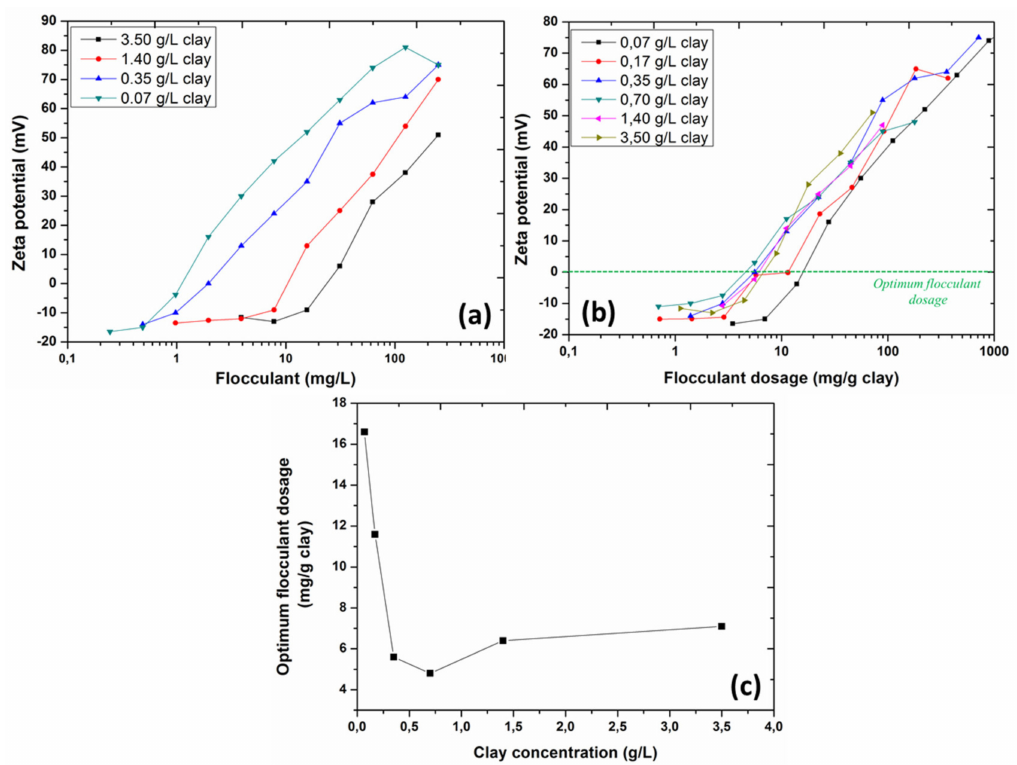
Figure 12. ( a , b ) Zeta potential as a function of cationic flocculant concentration (mg / L and mg / g clay) for di ff erent concentrations of clay. The dotted line represents the optimum flocculant dosage required to get the zero value of the zeta potential, ( c ) optimum flocculant dosage as a function of clay